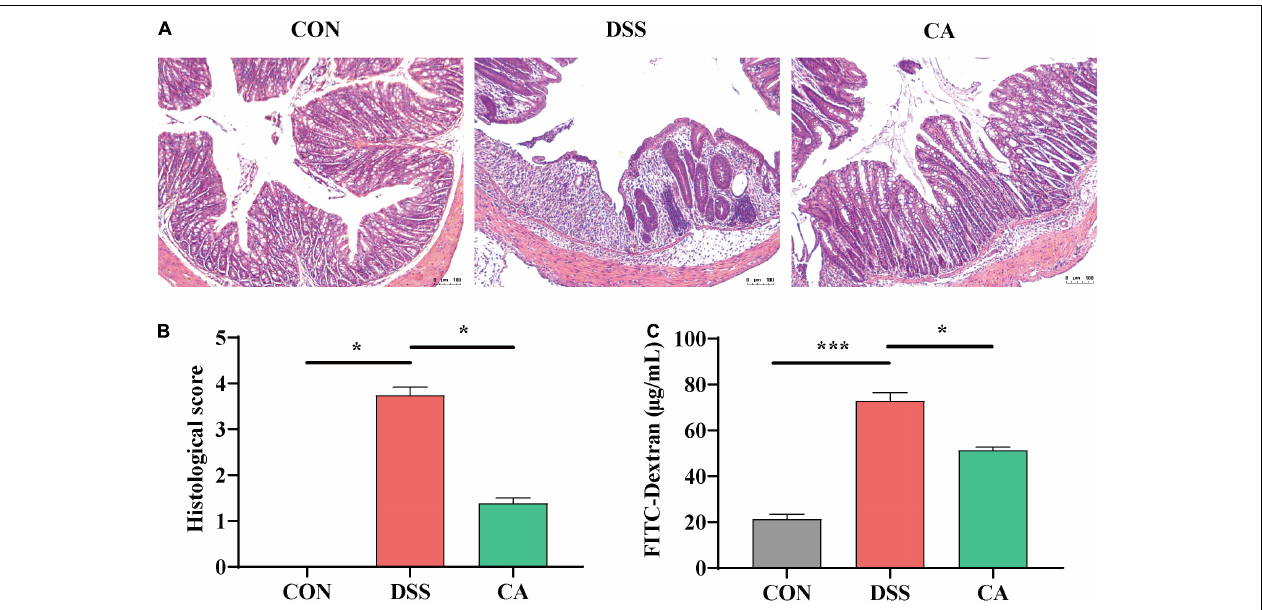
FIGURE 2 | Effects of CA supplementation on histopathological changes in DSS-induced mice colon. (A) Hematoxylin and Eosin (H&E) staining images of each group. (B) Histological score of each group. (C) Serum fluorescein isothiocyanate (FITC)-dextran levels of each group. Data are presented as mean ± SEM; n = 4. * p < 0.05 and *** p < 0.001 vs. the DSS-treated group on the same